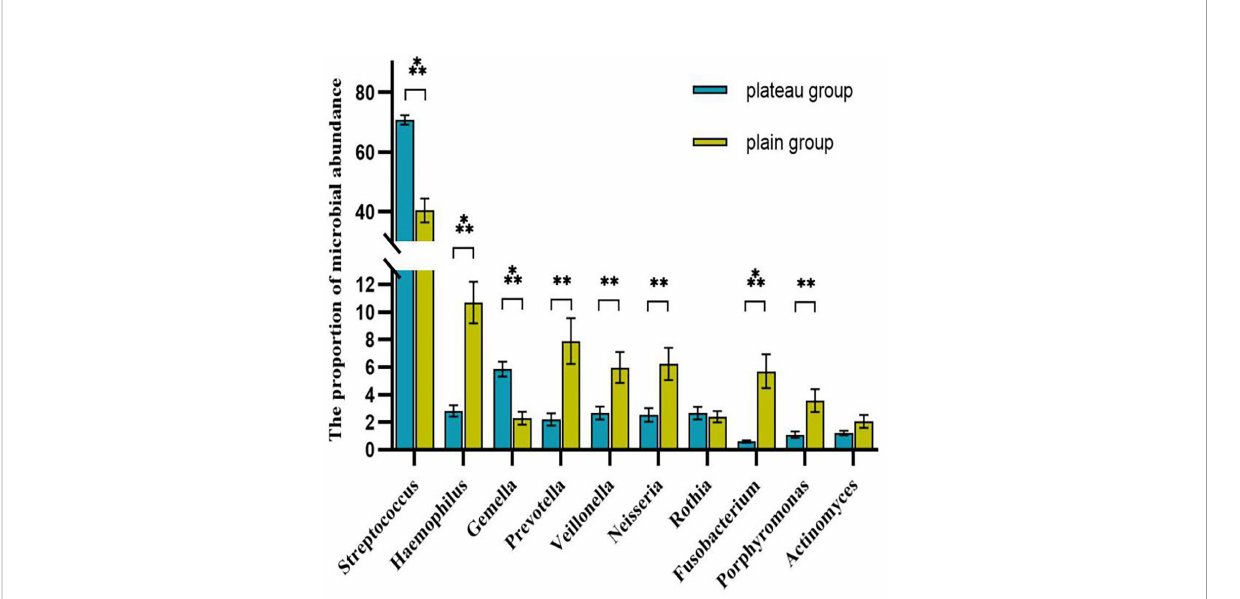
FIGURE 5 Comparison of the abundance of each genera between two groups (top 10 genera) The symbol above the columnar band indicated that the difference between groups was statistically signi fi cant. *** P < 0.001, ** P < 0.01. No statistical differences were found between groups without symbols.